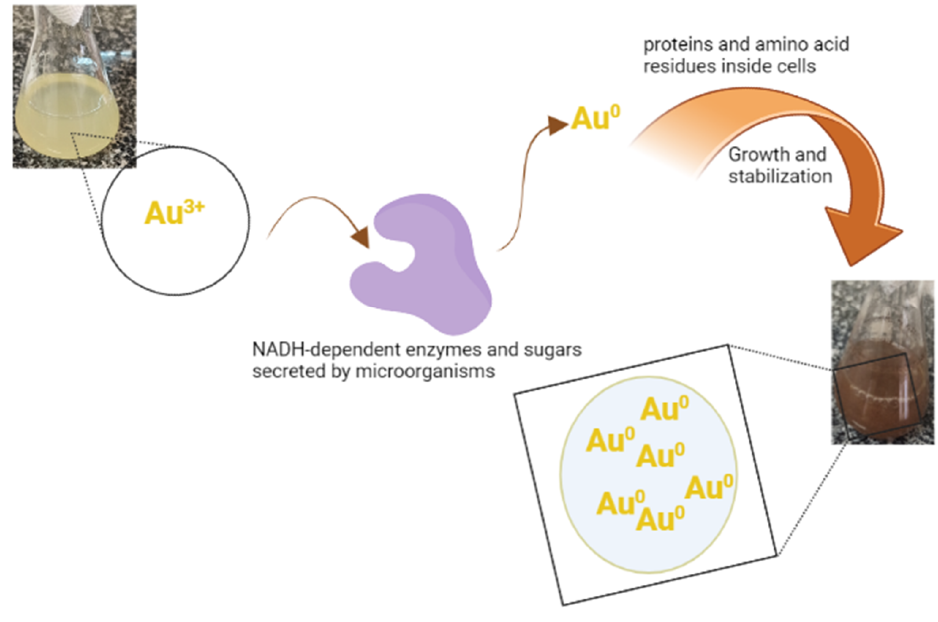
Figure 8. Schematic of synthesis, growth and stabilizing agents of biosynthesized